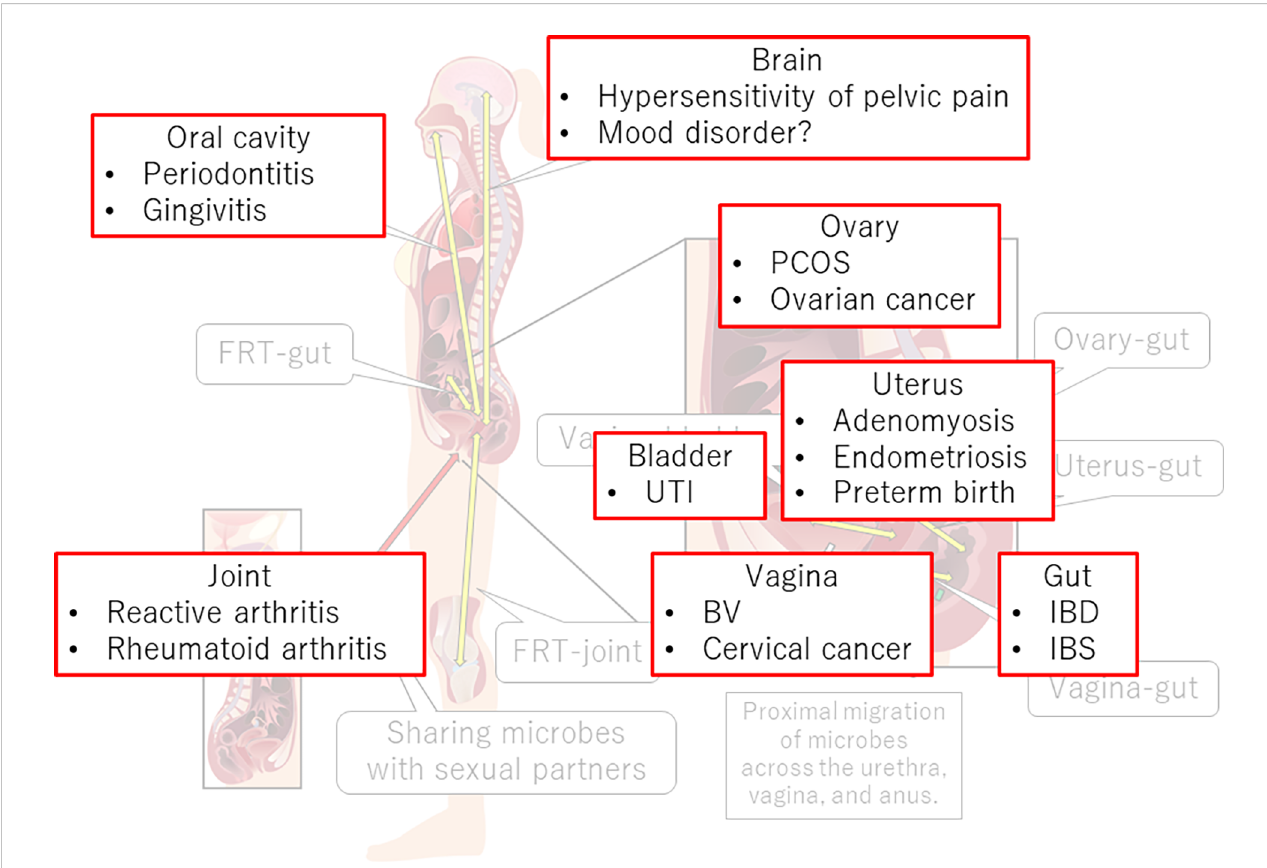
FIGURE 3 FRT-organ axes and diseases. Dysregulation of immune, neural, endocrine, or metabolic functions in the FRT-organ axes implicates its involvement in the pathogenesis of not only gynecological diseases but also diseases occurring apart from the FRT. PCOS, polycystic ovary syndrome; UTI, urinary tract infection; BV, bacterial vaginosis; IBD, in fl ammatory bowel disease; IBS, irritable bowel